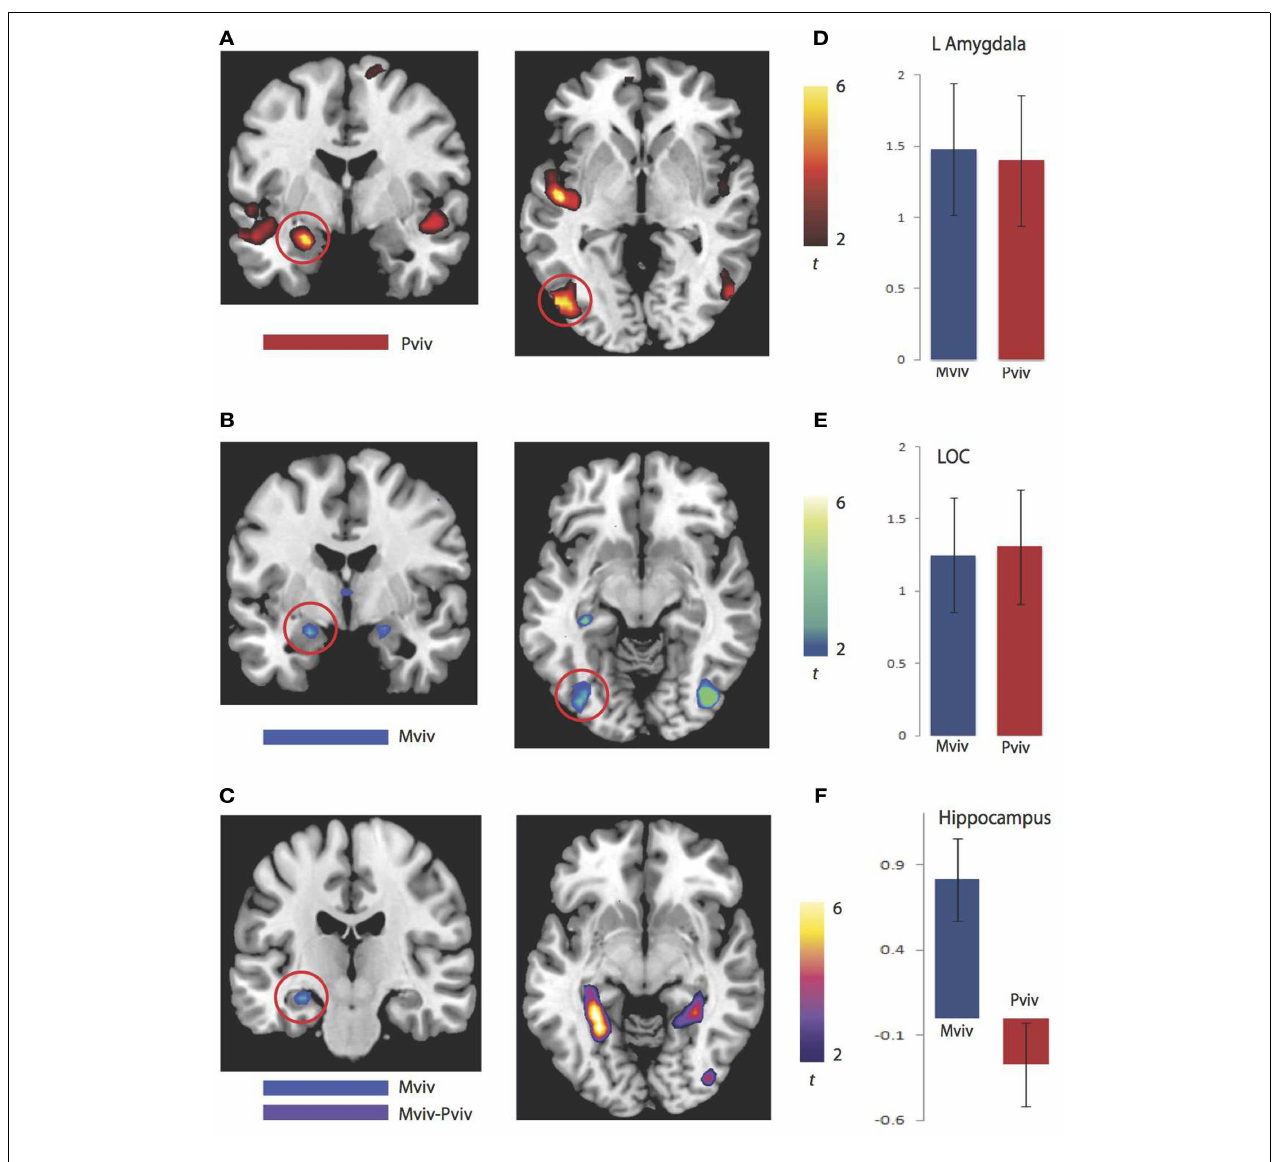
activated by Mviv and regions activated by the contrast Mviv > Pviv. (D) Contrast estimates for Pviv and Mviv for left amygdala. (E) Contrast estimates for Pviv and Mviv for left LOC. (F) Contrast estimates for Mviv and Pviv for left hippocampal region activated by